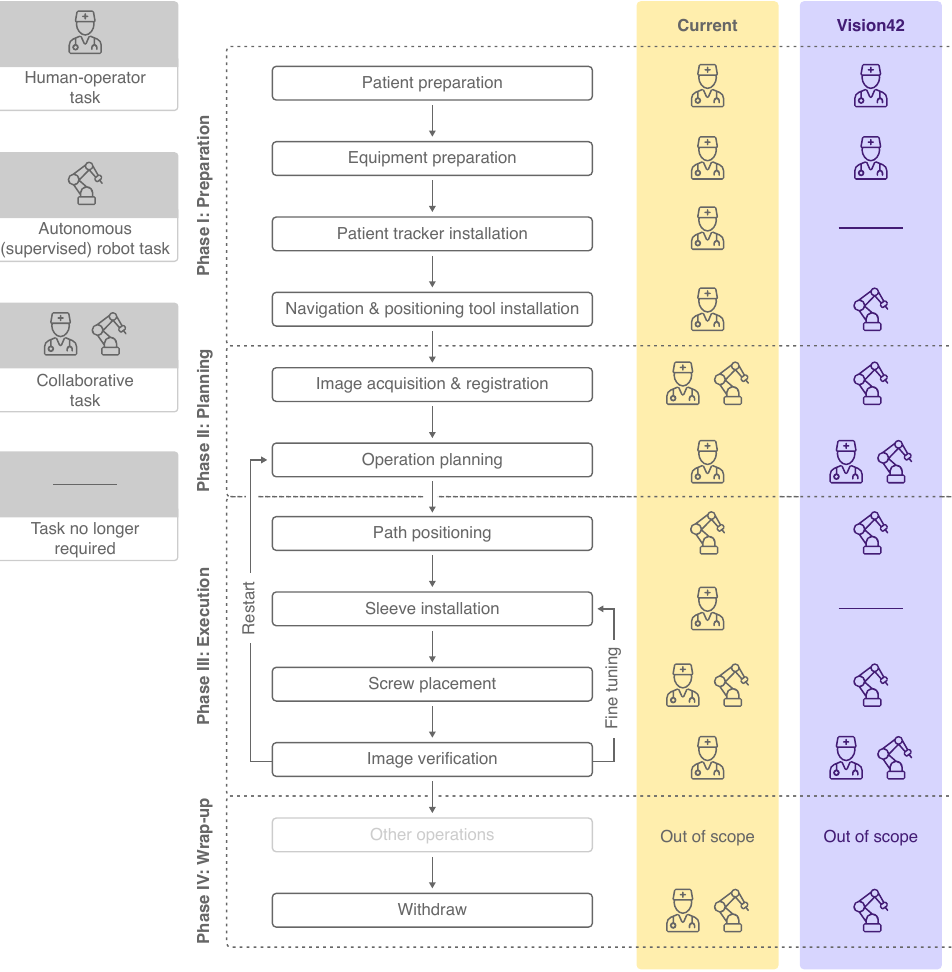
Figure 3. Workflow phases, subordinate steps and human-robot collaboration levels of a current PSP procedure [6] (yellow) and a futuristic PSP procedure (violet). The icons used are explained in the legend on the